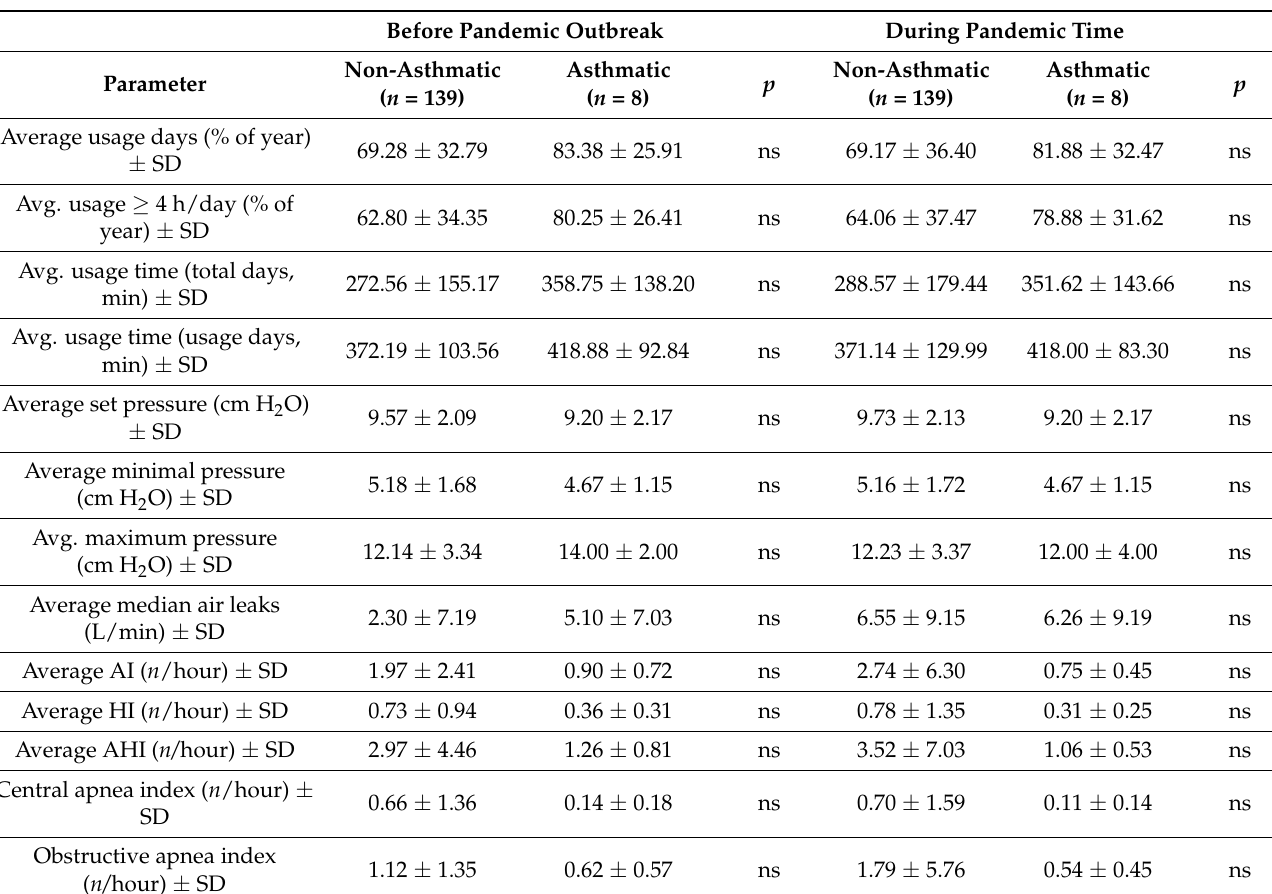
Table 7. CPAP therapy parameters and therapy adherence of asthmatic and non-asthmatic study participants before pandemic outbreak and during first year of pandemic